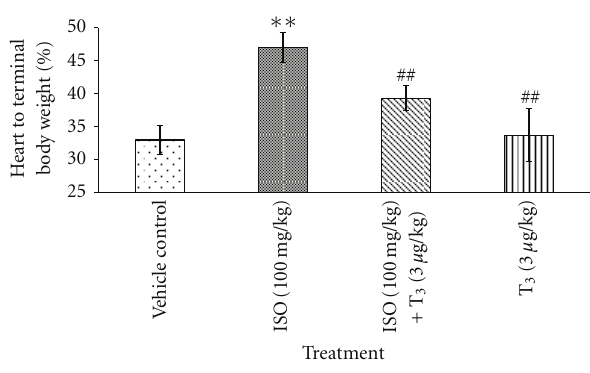
Figure 4: E ff ect of T 3 on heart weight. Values are presented as Mean ± SD, n = 5, ∗∗ : significant from control group at 1% level ( P < 0 . 05), ## : significant from ISO control group at 1% level ( P < 0 . 05), SD: Standard